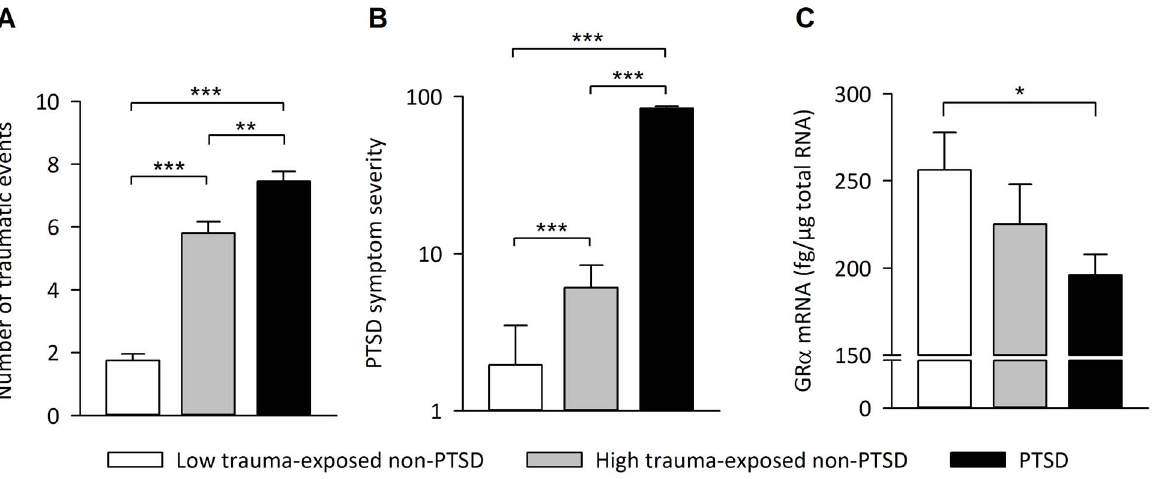
Figure 2. Relationship between trauma load and GR a isoform expression. (A) Number of different traumatic event types, (B) PTSD symptom severity, and (C) GR a mRNA expression levels in non-PTSD subjects with no or few traumatic experiences (0–3 traumatic event types; low trauma- exposed non-PTSD ; n =20), in non-PTSD subjects with substantial exposure to traumatic stressors (4–8 traumatic event types; high trauma-exposed non-PTSD ; n =15), and in PTSD patients ( n =42). Means and SEM are shown. * p , 0.05, ** p , 0.01, *** p , 0.001.